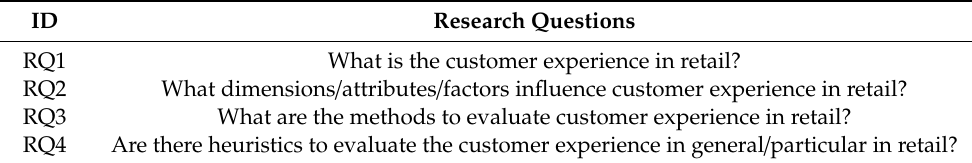
Table 1. Research questions defined in this